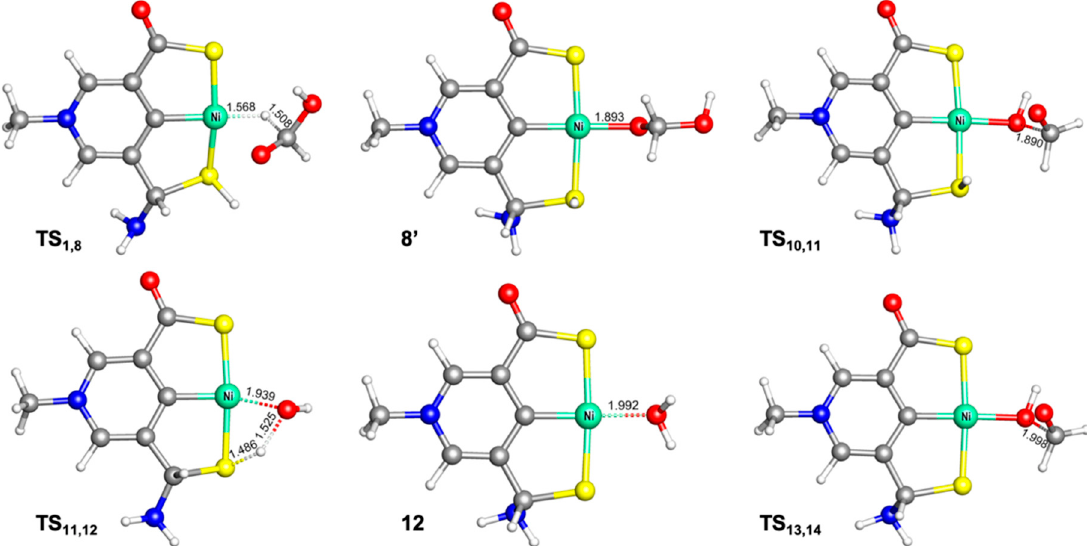
Figure 6. Optimized structures of TS 1,8 (508.7 i cm − 1 ), 8’ , TS 10,11 (262.4 i cm − 1 ), TS 11,12 (1352.3 i cm − 1 ), 12 , and TS 13,14 (189.9 i cm − 1 ). Bond lengths are in Å.